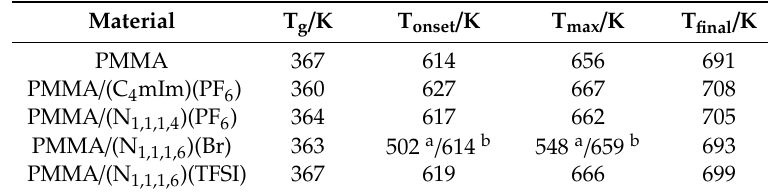
a,b correspond to values obtained for the first and second step of degradation,